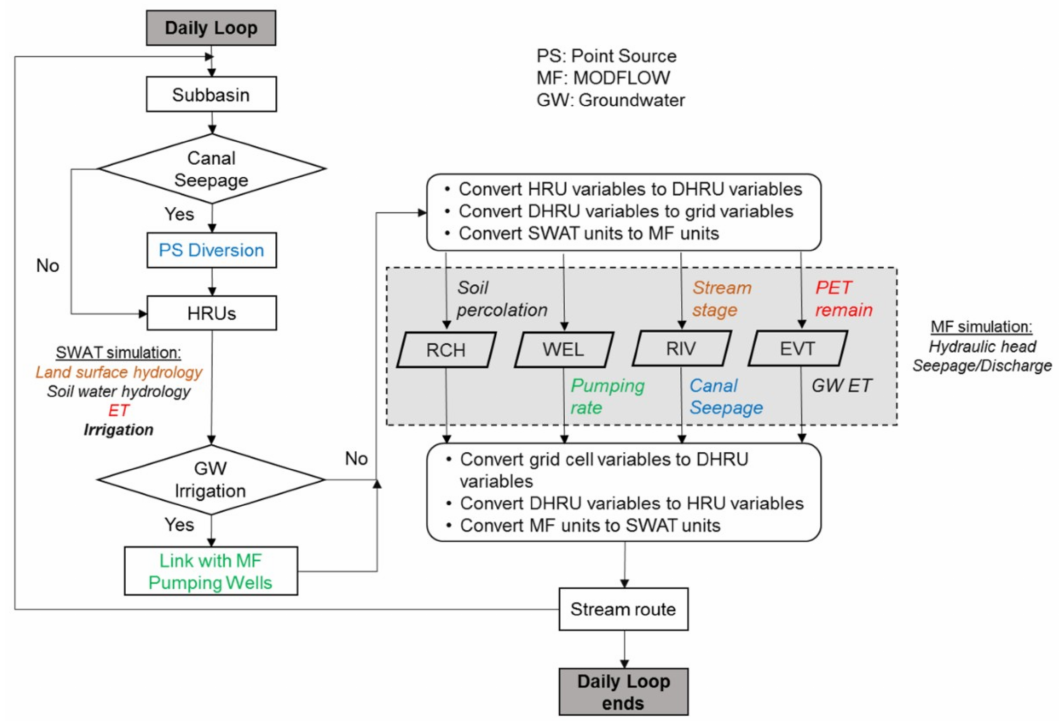
Figure 1. Flow of information in modified Soil and Water Assessment Tool (SWAT)-MODFLOW modeling structure, with MODFLOW called as a subroutine within the main SWAT FOTRAN